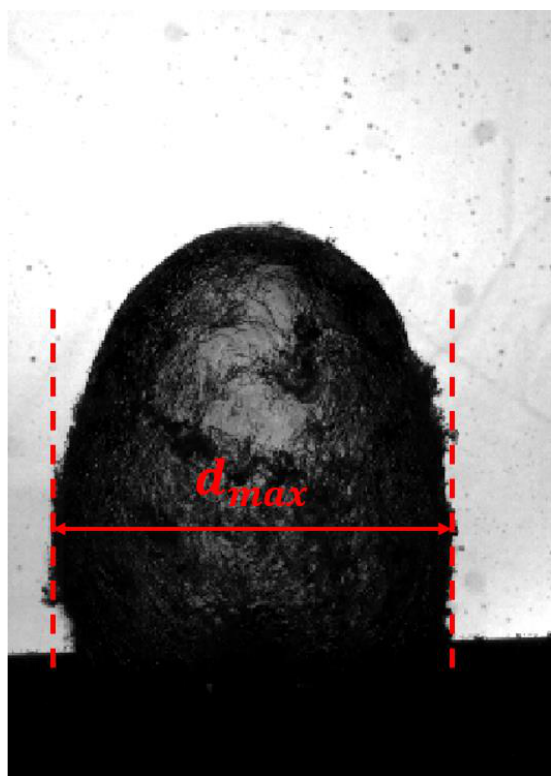
Figure 3. The ‘pear - like’ shape of the airgun bubble in a free field. Figure 3. The ‘pear-like’ shape of the airgun bubble in a free field. According to energy conservation before shot and maximum bubble volume after According to energy conservation before shot and maximum bubble volume after shot, one can derive a simplified relation between d max and P 0 . Just before the shot, there is d and P . Just before the shot, there shot, one can derive a simplified relation between max 0 potential energy, E p , conserved in the bubble [34–36] as is potential energy, E p , conserved in the bubble [34 – 36] as